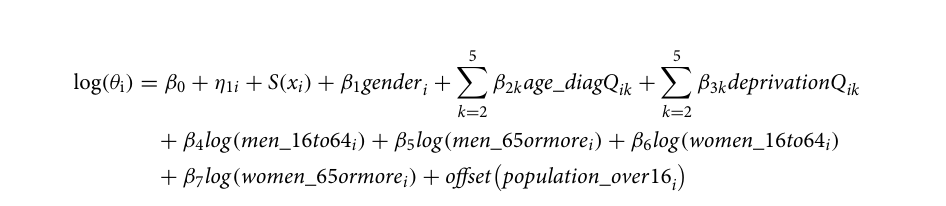
Table 1. Descriptive analysis of demographic and clinical characteristics by region for each of the diagnostic categories. Amyotrophic Lateral Sclerosis (ALS). a First row: mean (sd). Second row: median (1st–3rd quartiles). Third row: